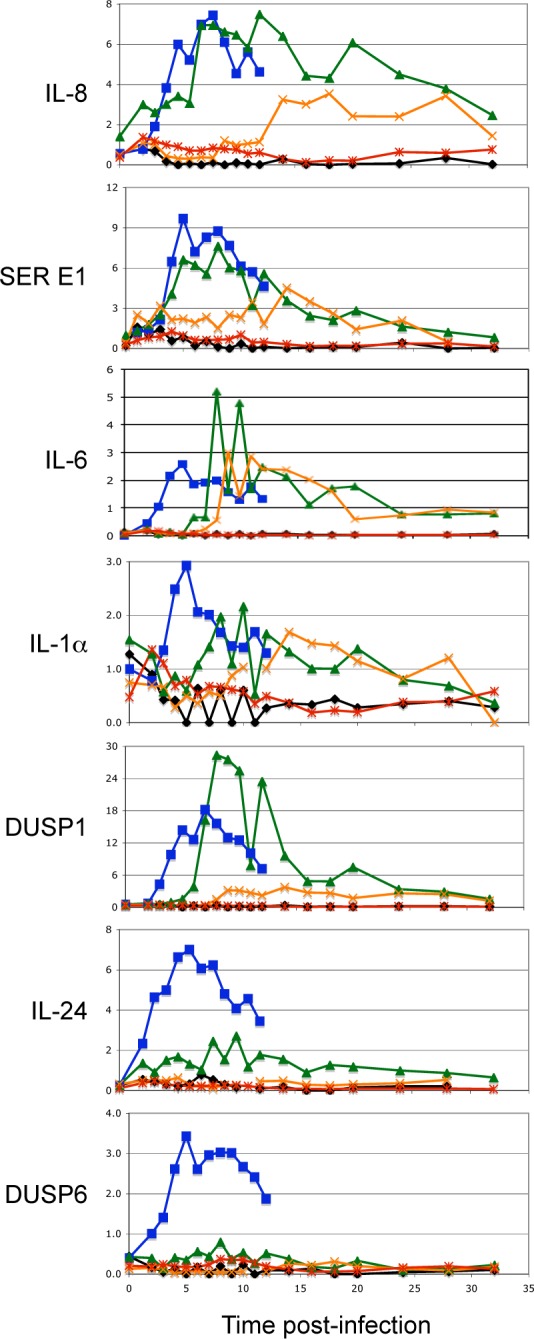
Effect of C. albicans mutations on host transcriptional responses.RT-PCR for IL-8, SERPIN E1 (SER E1), IL-6, IL1⍺, DUSP1, IL-24, and DUSP6 transcription, expressed in relative ng (y-axis). cDNA derived from mRNA purified from FaDu epithelial cell monolayers infected with wild-type C. albicans (■), rim101Δ/Δ (▲), mutant cells, efg1 cph1Δ/Δ (×) mutant cells, S. cerevisiae (*), or non-infected (◆) at defined time points (x-axis). A single time course experiment is shown, but analogous results were obtained in two replicate experiments.